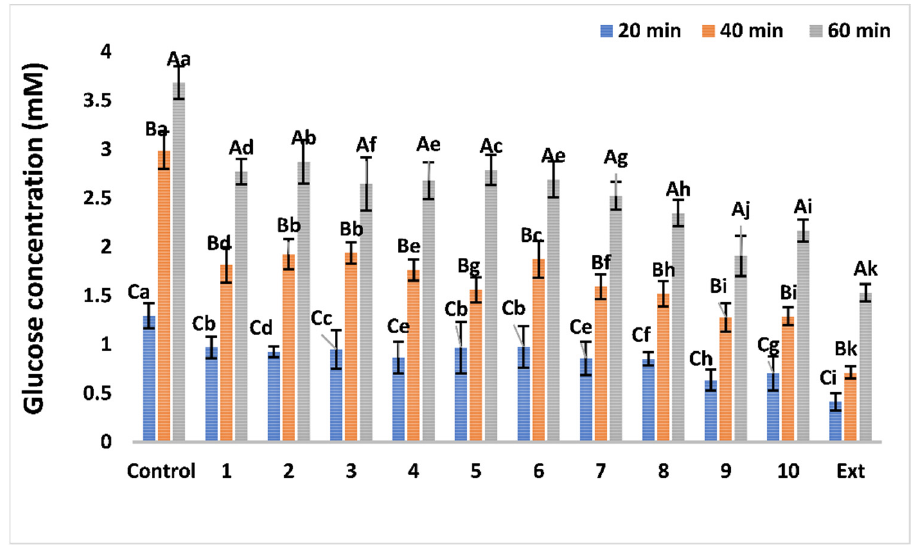
Figure 7. Effect of G. abyssinica extract and isolated bioactive compounds on the rate of glucose diffusion. Lower-case letters indicate significant differences ( p < 0.05) between treatment conditions and upper-case letters indicate significant differences ( p < 0.05) between time conditions. Data are presented as the means ± standard deviations.